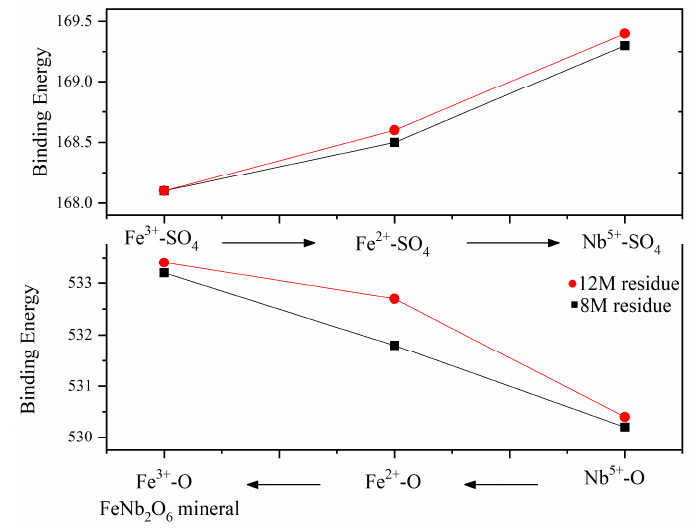
Figure 6. The binding energy sequence of each bond.